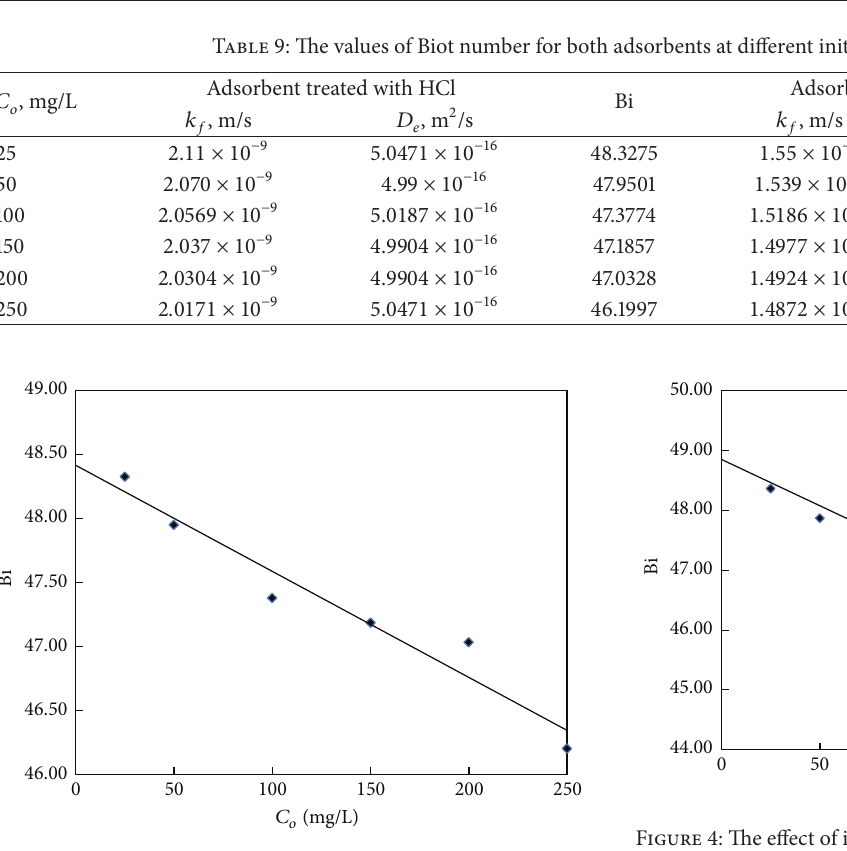
Figure 3: The effect of initial concentration on the Biot number for adsorbent treated with HCl.